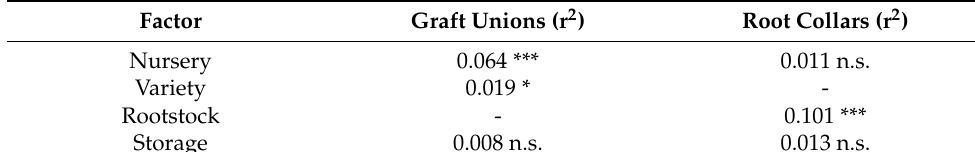
Table 2. Contribution of nursery, variety/rootstock and storage to variation in necrosis in graft unions and root collars. Annotation next to the numbers indicates significance level: *** < 0.001, * < 0.05, n.s. = not significant (>0.05).